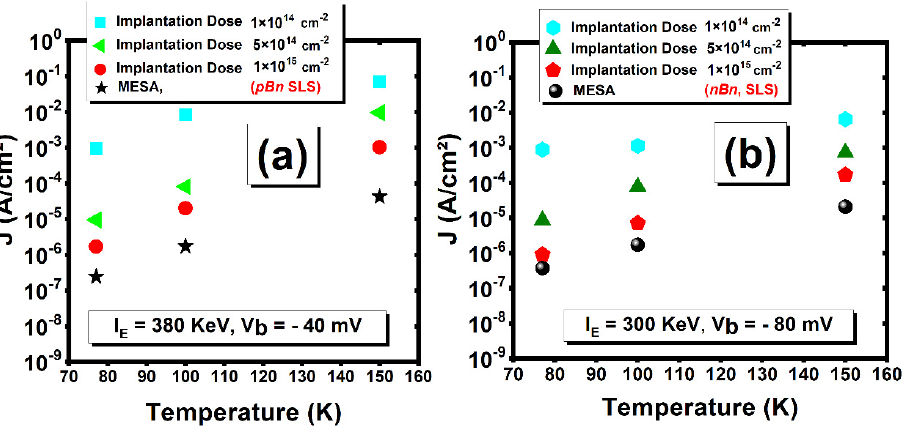
Figure 3. ( a ) Dark current values versus temperature for the planar MWIR SLS diodes: ( a ) pBn (V b = − 40 mV, 380 KeV implantation dose) and ( b ) nBn (V b = − 80 mV, 300 KeV implantation dose) fabricated with different implantation doses. All diodes were circular with a 200-µm diameter. Table 1. Optimized implantation parameters for the pBn and nBn designs.